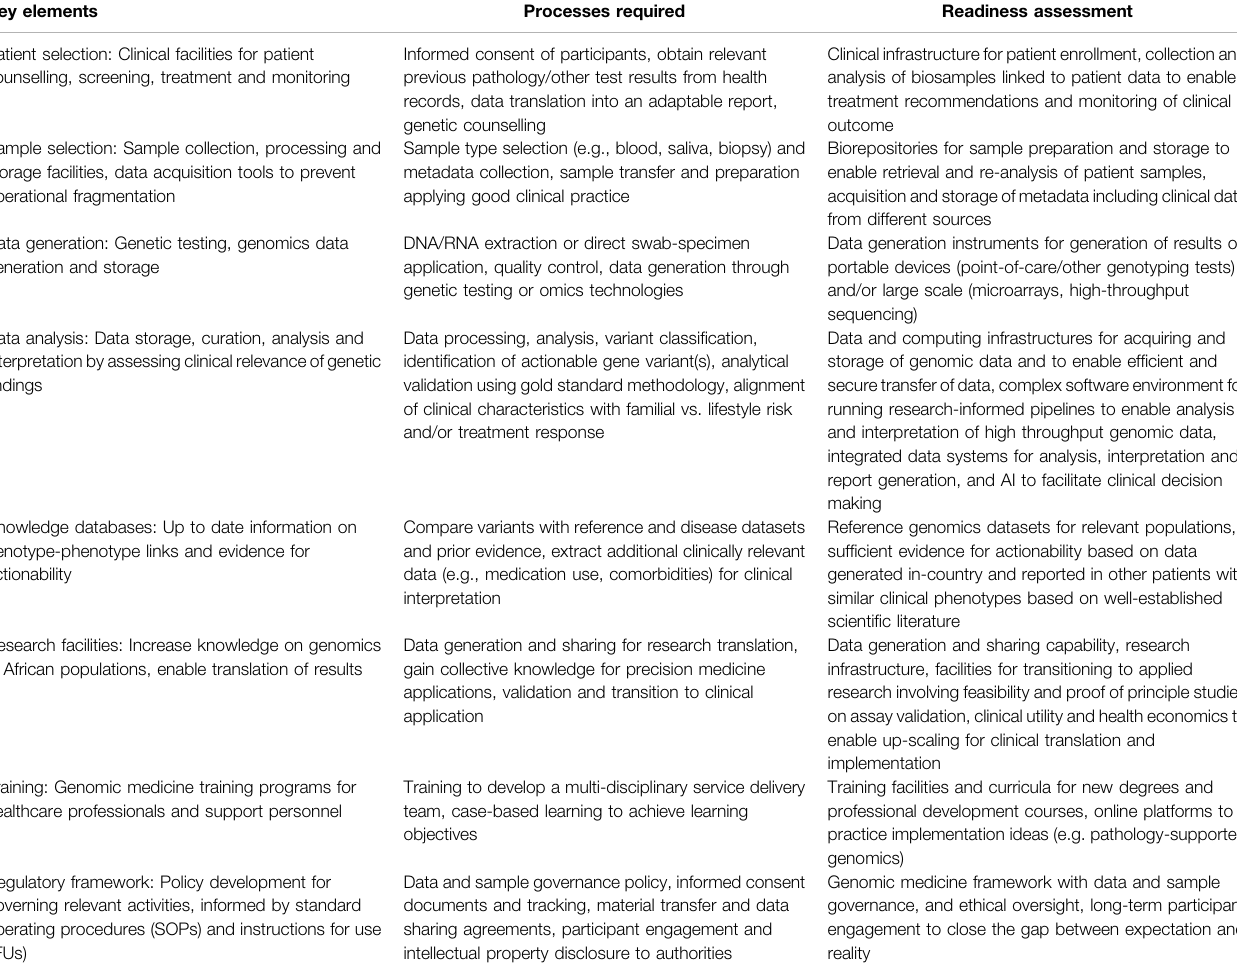
TABLE 1 | Checklist with key requirements to assess readiness of African countries prior to implementation of genomic medicine programs. Key